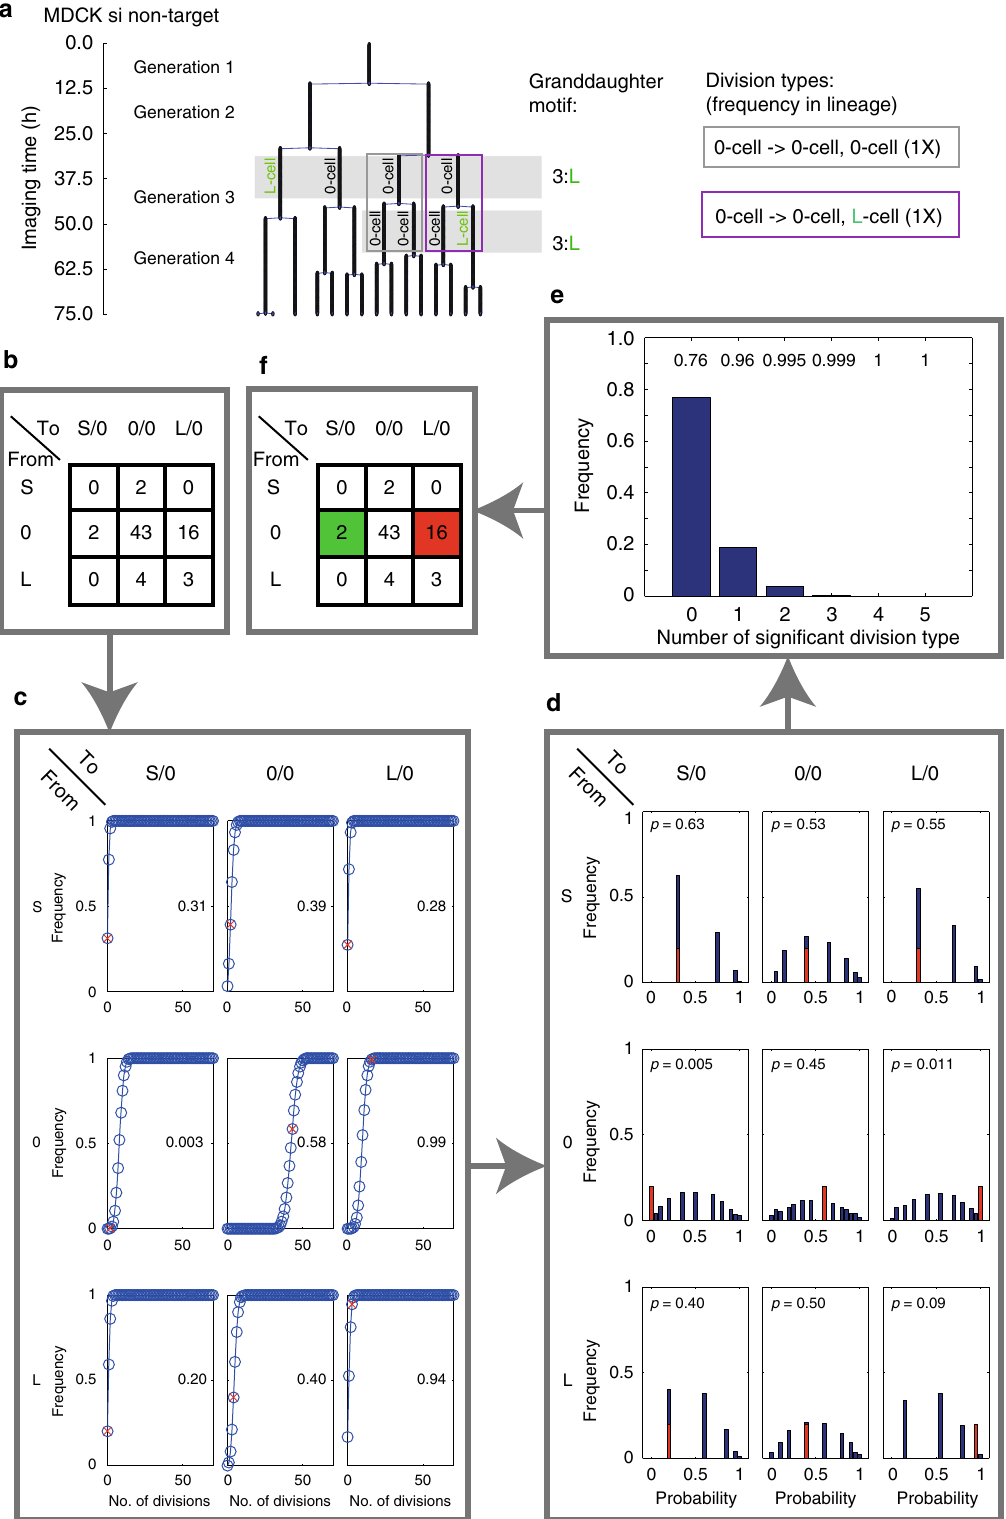
seemingly due to cell-intrinsic and not external differences. daughter – daughter and granddaughter pairs are more similar Consistently, the median cell cycle duration (si ninein: 14 h, si compared with the si non-target condition (Fig. 1c). In addition, non-target: 16.2 h) and variance (Fig. 1a) are reduced in si ninein in si ninein-treated cells, both the 3:L and the 3:S diversity motifs lineages compared with si non-target lineages. The cell cycle occurr at stochastic frequencies (Fig. 2c). Hence, the data are durations of even the mother – daughter pairs but also consistent with the statement that the differences in cell cycle NATURE COMMUNICATIONS| (2019) 10:1901